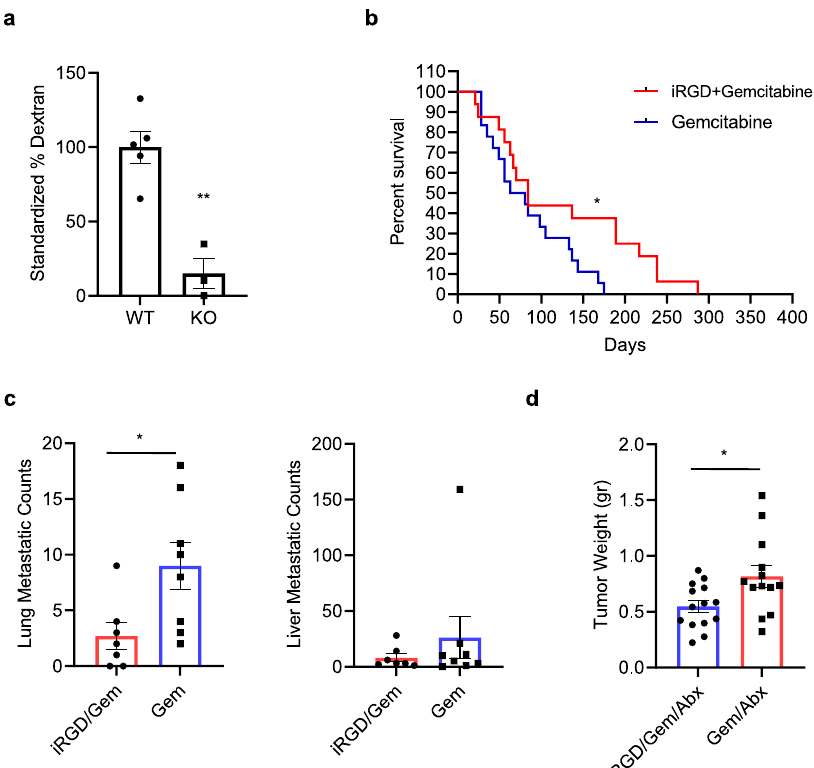
Fig. 6 iRGD co-injection potentiates co-administered chemotherapy in KPC mice. a IV delivery of fl uorescent dextran by iRGD co-injection to orthotopic PDAC created with LM-PmC cells (WT; n = 5) or the β 5 integrin-de fi cient D3 clone (KO; n = 3) in mice. Two-tailed unpaired Student ’ s t test; p = 0.002. b Kaplan – Meier survival curve of KPC mice treated with gemcitabine alone ( n = 18) or in combination with iRGD ( n = 16). Log-rank (Mantel – Cox) test; p = 0.0385, HR = 0.53. c Numbers of metastatic lung (left) and liver (right) nodules identi fi ed in the mice from ( b ). iRGD/Gem ( n = 7); Gem ( n = 8). Two- tailed unpaired Student ’ s t test; p = 0.0263 (lung metastasis), p = 0.4 (liver metastasis). d The weight of tumors harvested from KPC mice treated with iRGD + gemcitabine + nab-paclitaxel ( n = 14) or gemcitabine + nab-paclitaxel alone ( n = 13) for 6 weeks. Two-tailed unpaired Student ’ s t test; p = 0.0193. All error bars, SEM; * p < 0.05; ** p < 0.01. Source data provided in Source Data fi